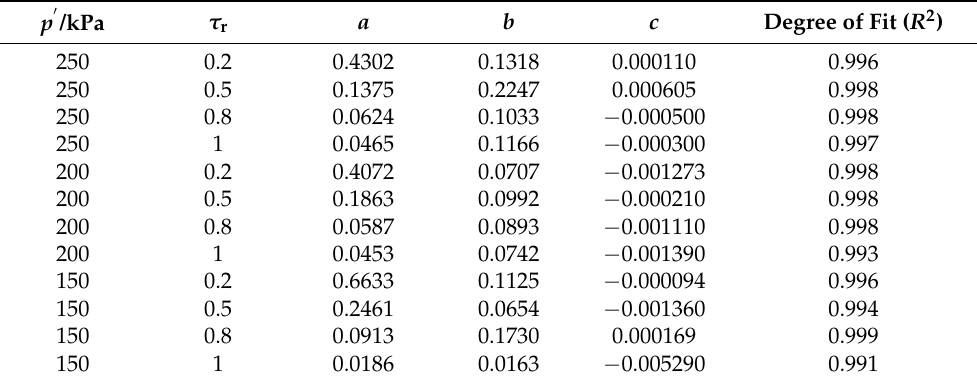
Table 5. Parameters of predicted curves.